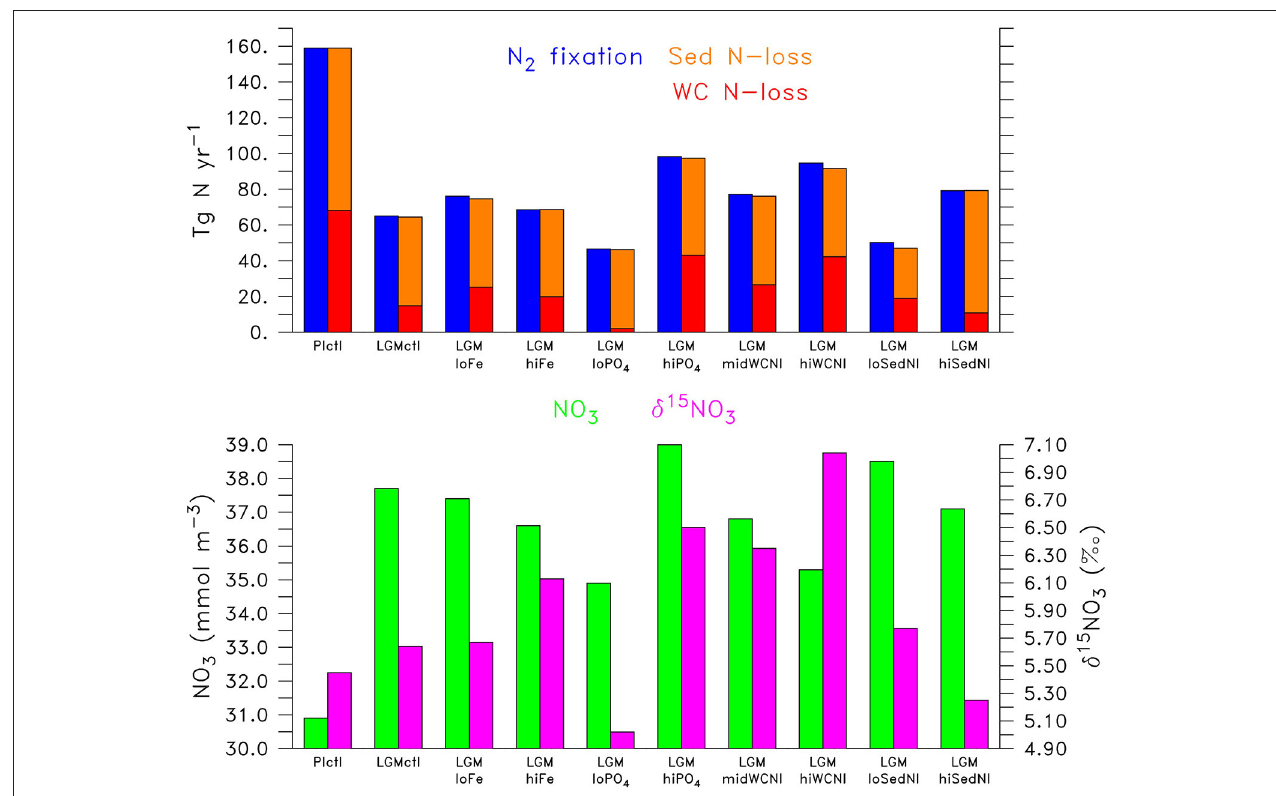
FIGURE 6 | (Top) Global N 2 fixation (left blue bar), water column N-loss (right red bar), and sedimentary N-loss (right orange bar) for the simulations. (Bottom) Global NO − 3 (left green bar) and global δ 15 NO − 3 (right magenta bar) for the